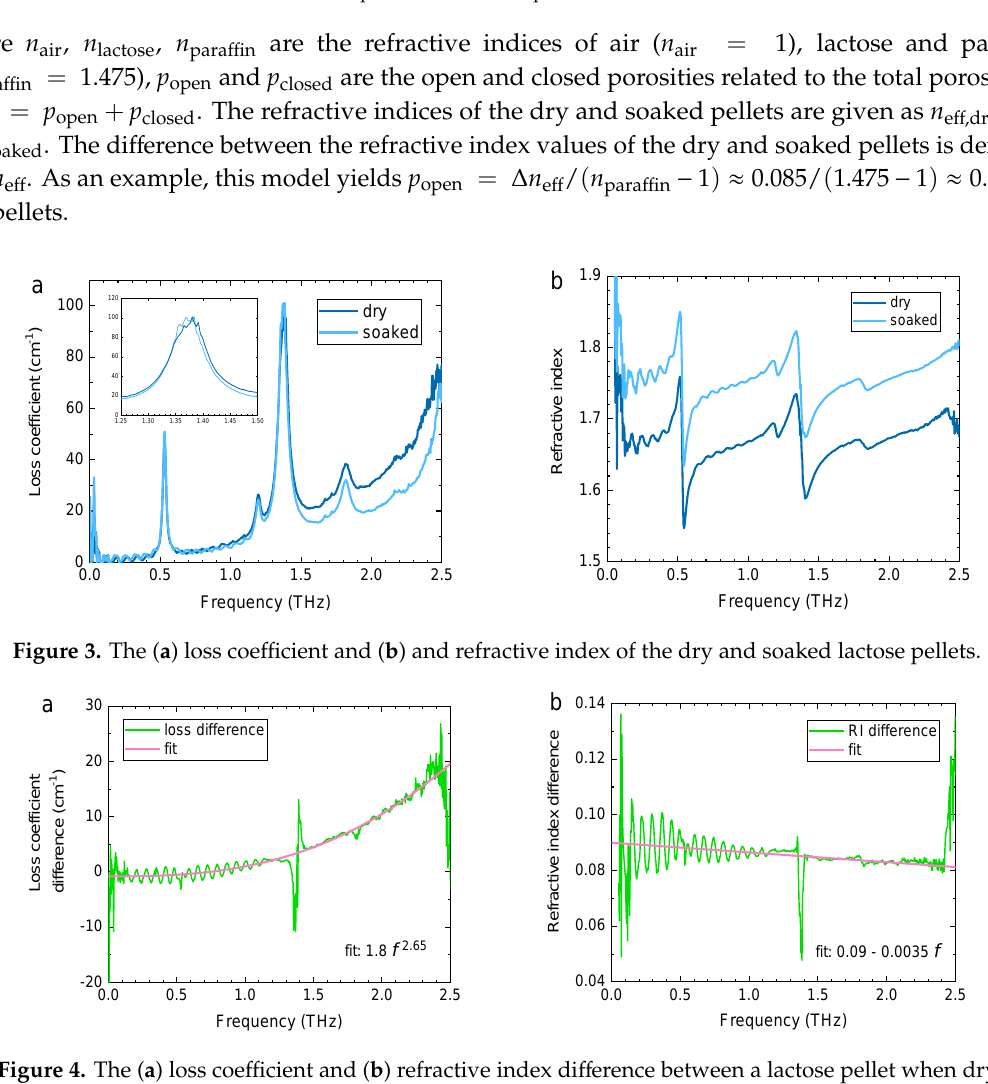
Figure 4. The ( a ) loss coefficient and ( b ) refractive index difference between a lactose pellet when dry and when soaked in paraffin. Solid lines are fits to the data.